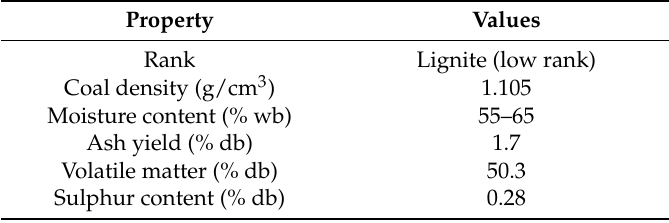
Table 1. Approximate analysis of Latrobe Valley brown